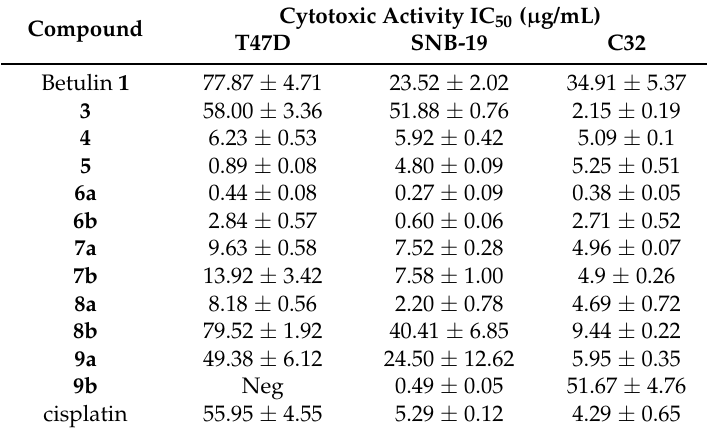
Neg—negative in the concentration